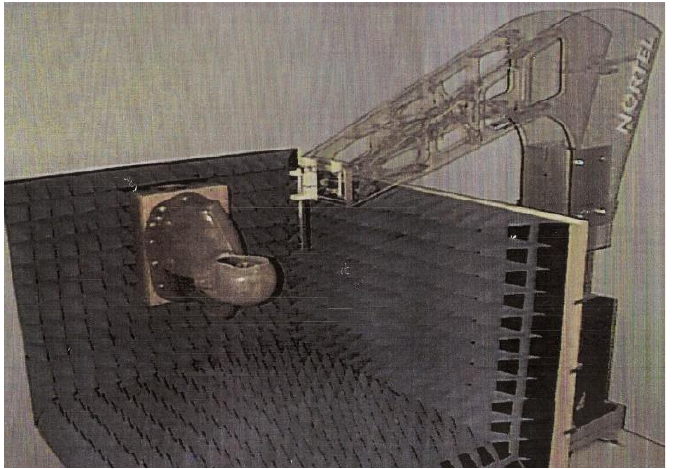
Figure 3. Experimental measurements of SAR used simple head shapes filled with homogeneous